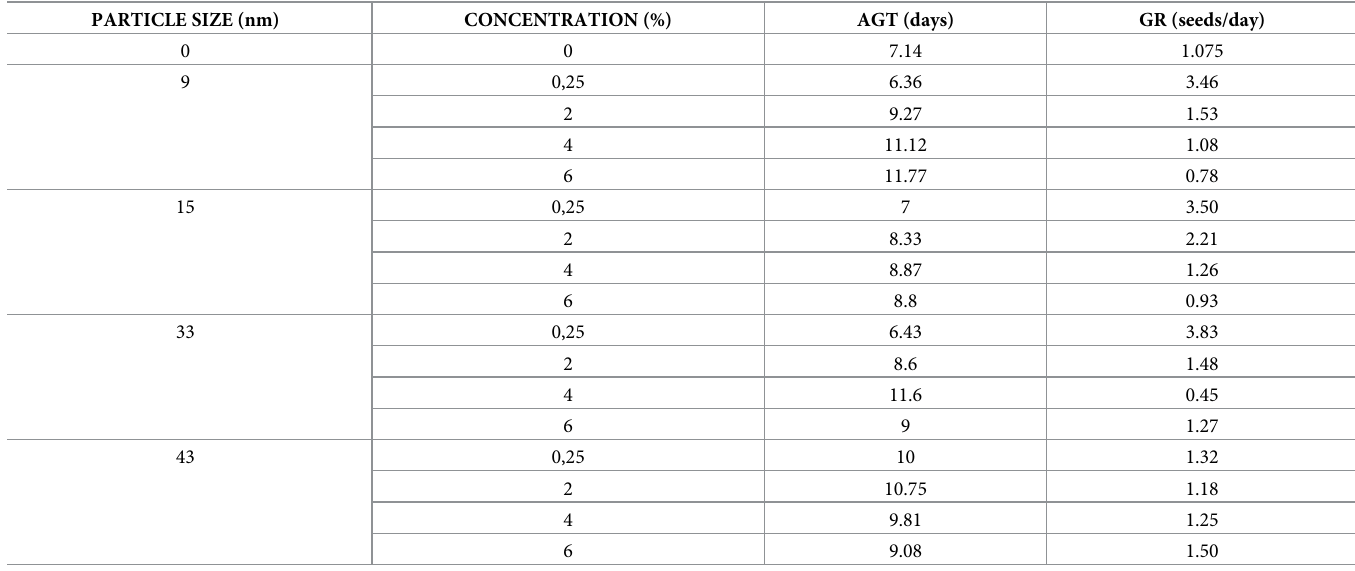
Table 4. Average Germination Time (AGT) and Germination Rate (GR) of spinach seeds, inoculated with the suspension of TiO 2 powder. PARTICLE SIZE